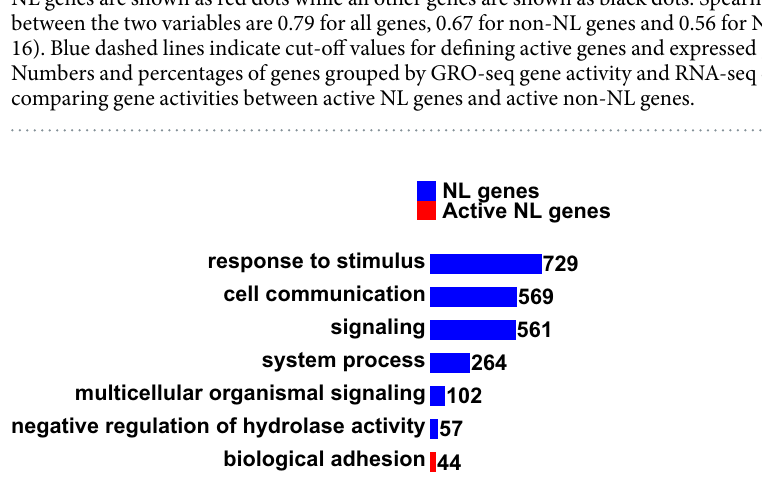
Figure 2. GO analysis of NL genes. The presented Biological Process categories are enriched with Family Discovery Rates (FDRs) < 0.05. Bar lengths are proportional to gene numbers (displayed on the right end). Note that some child GO categories of the displayed parent GO categories are also enriched (see the complete list in Supplementary Table